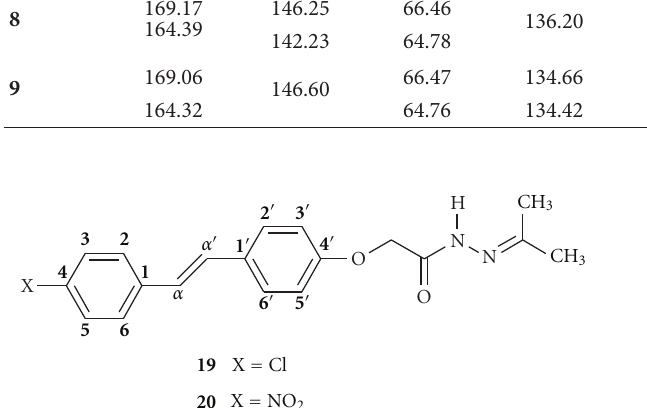
as N-acyl substituted hydrazones of pyridinecarboxaldehydes are present in dimethyl-d sulfoxide solution in the form of geometric (E)-isomers about C=N double bond [27]. (E)- 6 con�guration in the stilbene part of the molecules of